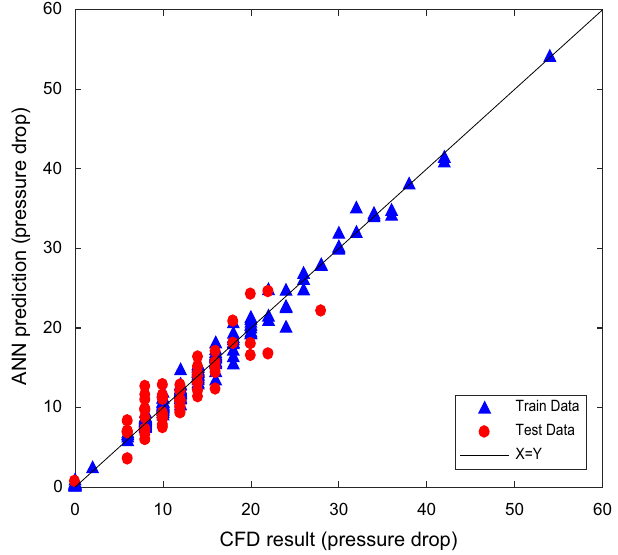
Figure 5. Validation of predicted versus calculated condensate pressure drop for train and test